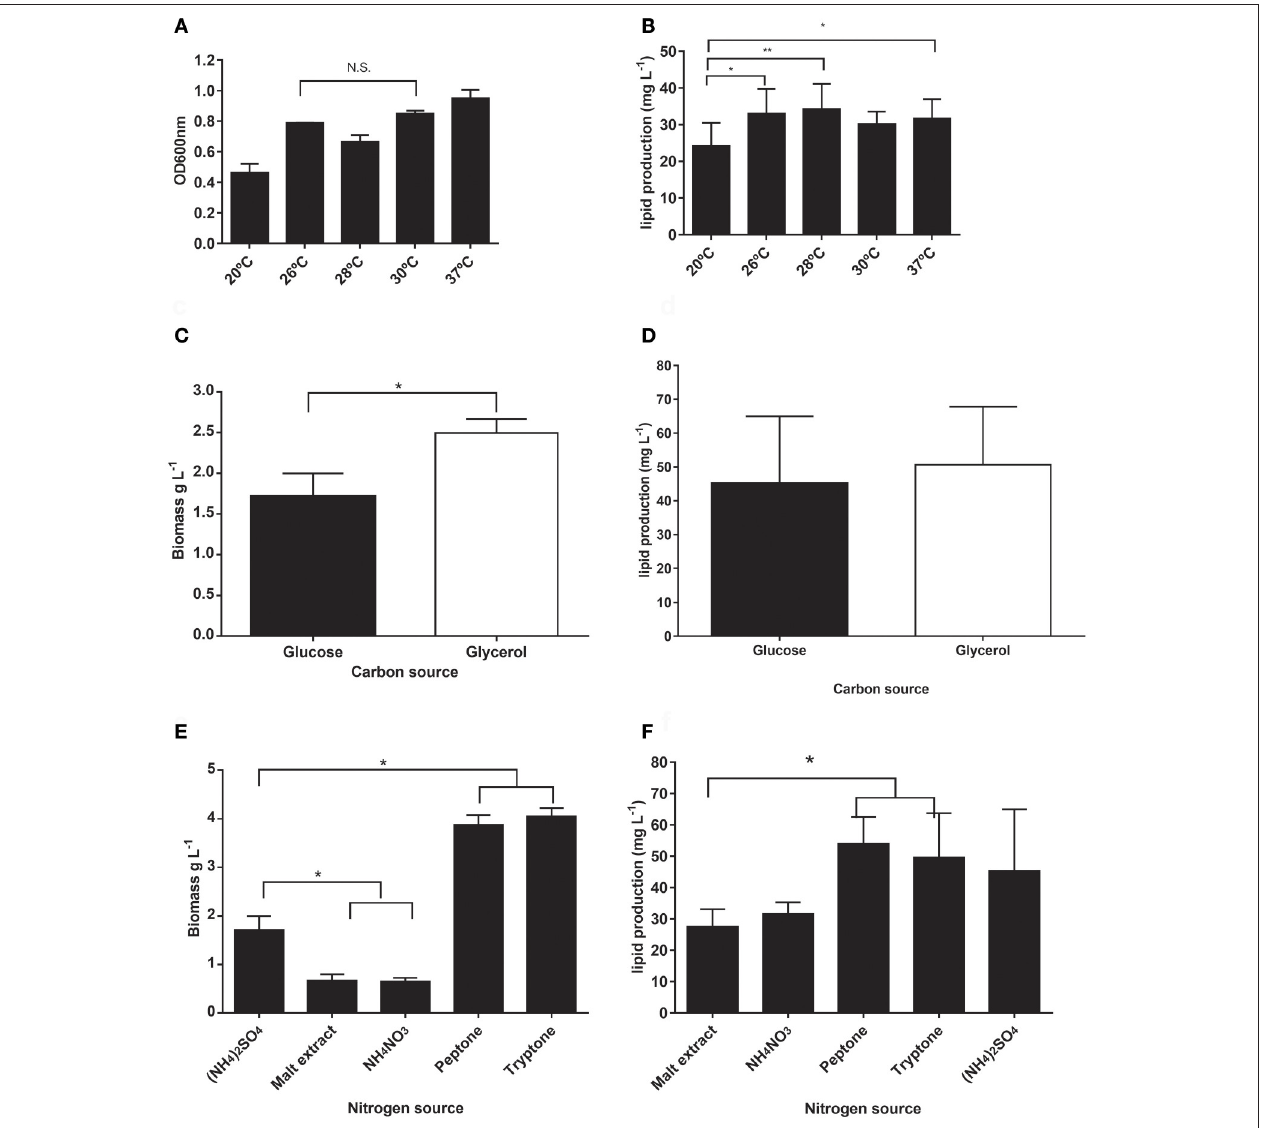
FIGURE 3 | (A,B) Comparison of different temperatures in optical density (OD600 nm) and lipid production (mg/L) of M. guilliermondii BI281A. (C,D) Assessment of glucose and glycerol as carbon source, and (E,F) different nitrogen sources in M. guilliermondii BI281A biomass (g/L) or lipid (mg/L) production after 72 h of cell growth, 26 ◦ C, 150 rpm (medium A). All experiments were assessed independently by biological and technical triplicates. * P < 0.05, ** P < 0.01, N.S., Non-significant.